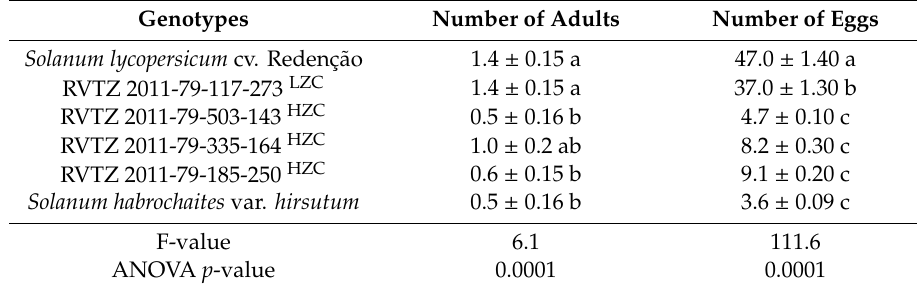
Table 4. Number (± standard error) of Tuta absoluta adults and eggs on the adaxial and abaxial sides of leaflets of tomato genotypes in a choice bioassay ( n = 10).